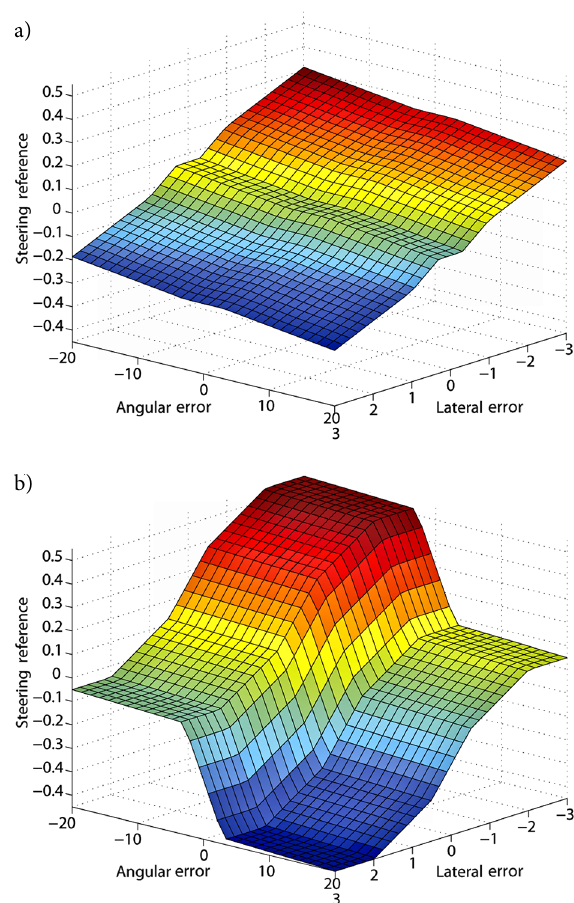
Fig. 7. Control surfaces for lateral control: